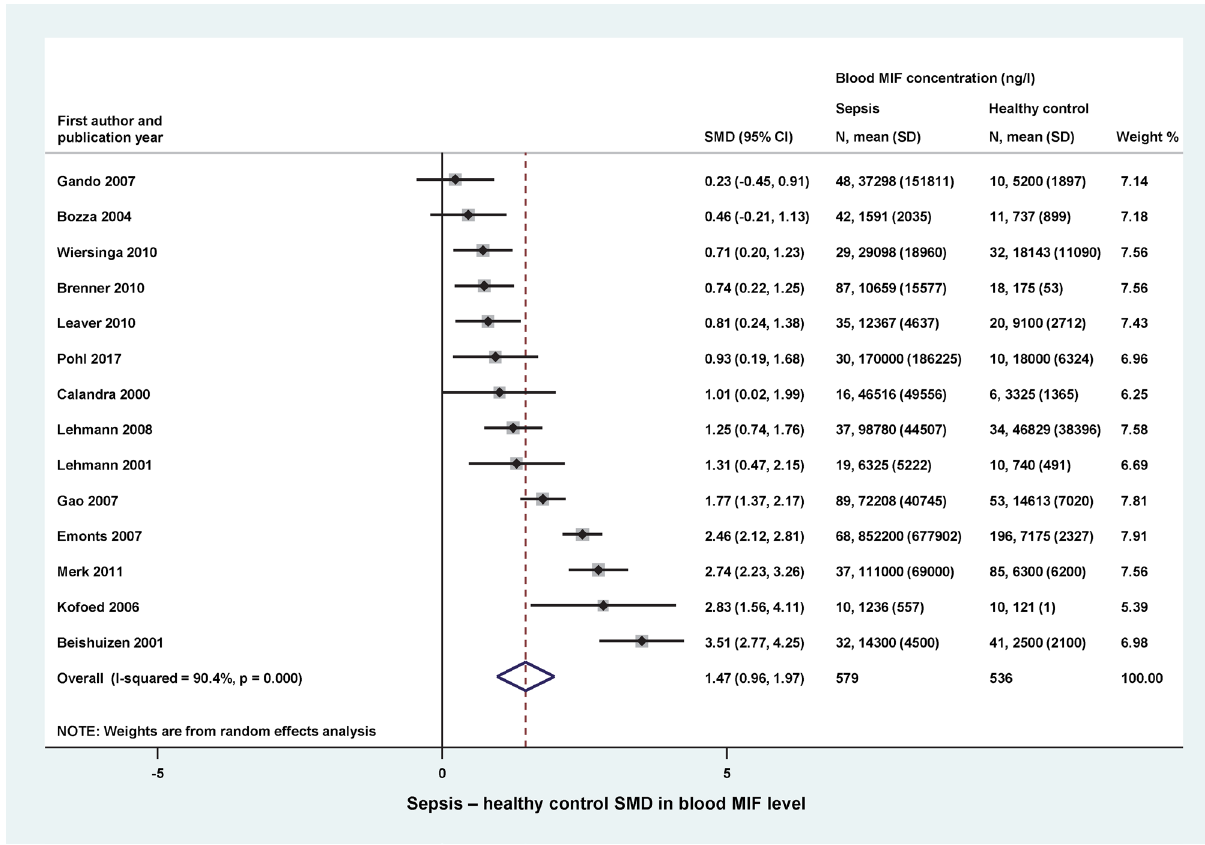
Figure 2. Forest plot of standardized mean differences (SMDs) in blood levels of macrophage migration inhibitory factor (MIF) between septic patients and healthy controls. Here, and in Figs. 3, 5, and 6 black diamonds represent the SMD for each study, while the left and right horizontal arms of the diamonds indicate the corresponding 95% confidence intervals (CIs). The size of the gray box surrounding the diamond is proportional to the relative weight of the study. The open rhombus on the bottom represents the average SMD calculated from the SMDs of all individual studies. The left and right vertices of the rhombus represent the CIs of the average SMD, while the vertical diagonal and the dashed line indicate the average SMD of all studies in the forest plot. A negative SMD indicates higher MIF levels in healthy controls, whereas an SMD greater than zero indicates increased MIF levels in sepsis. SD standard